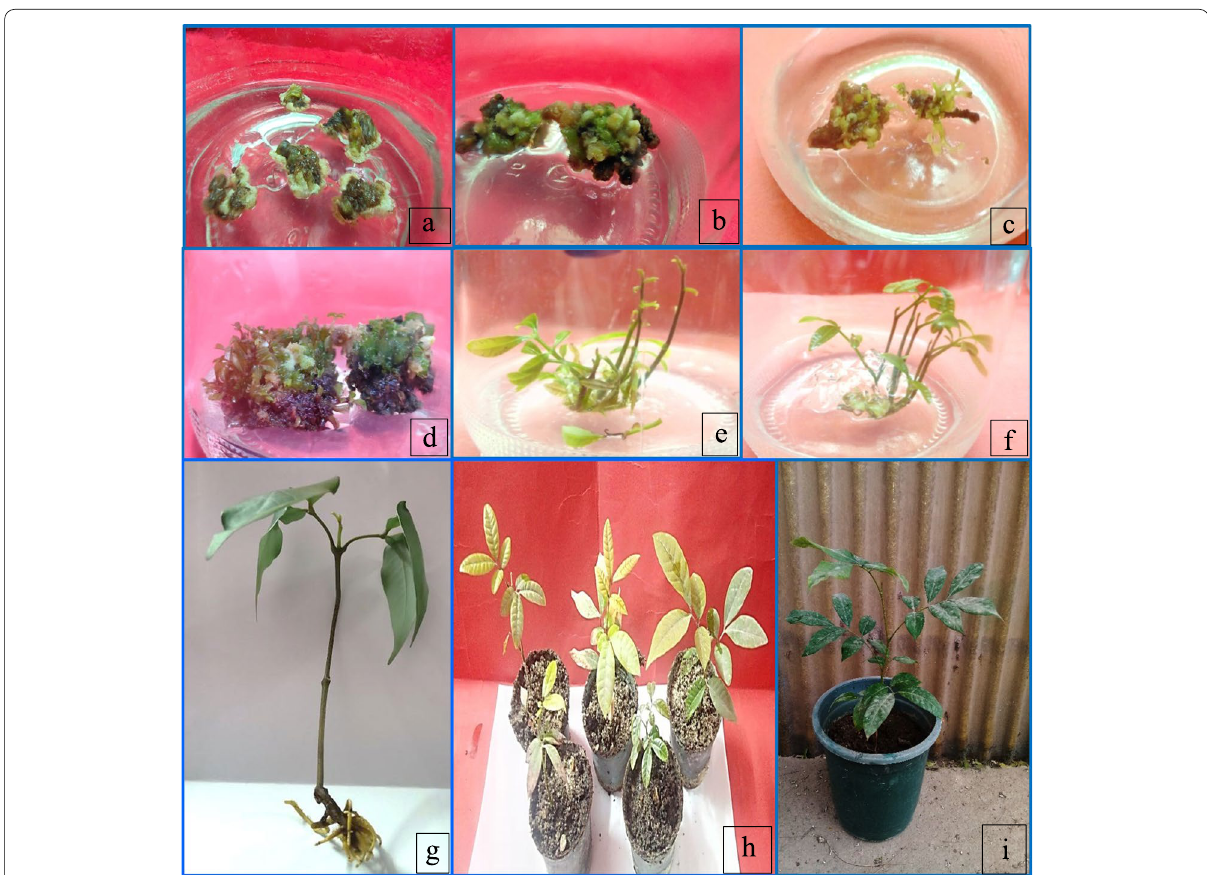
Fig. 2 Organonenesis stages of longan ( Dimocarpus longan ) plants. a Swelling degree of leaf buds on MS medium containing 1.0 mg/l TDZ. b Organogenesis induction from explants cultured on medium containing 1.0 mg/l TDZ. c , d Organogenesis numbers of longan cultured on medium containing 1.0 mg/l TDZ. e Development of organs cultured on medium containing 1.0 mg/l TDZ after 8 weeks. f Elongated shoot formation on medium containing 3.0 mg/l